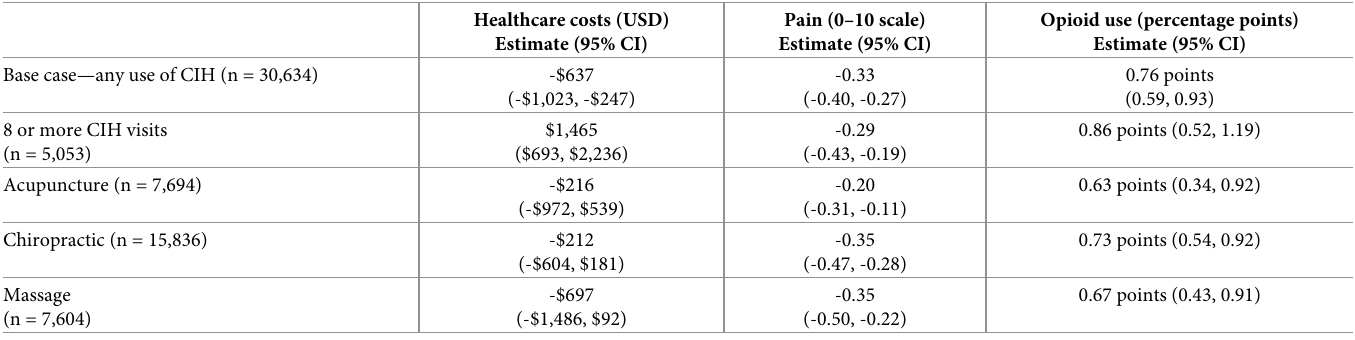
Table 3. Results of the sensitivity